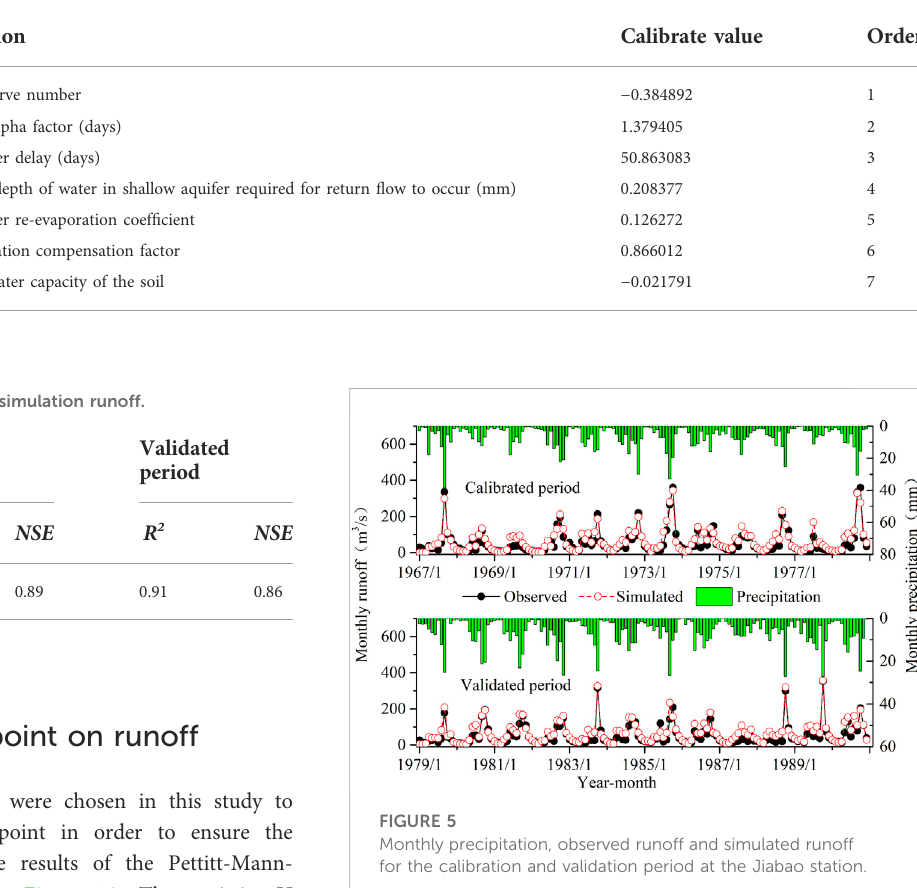
TABLE 2 Sensitivity Parameters used in the SWAT model.